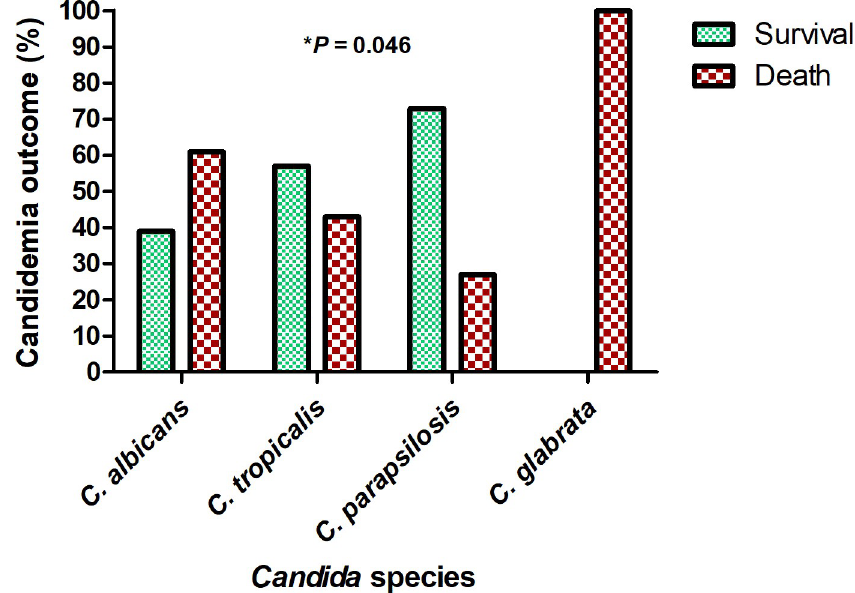
Fig 3. Outcome of candidemia according to the Candida species in a tertiary hospital in Northeast Brazil. � Chi- square ( X 2 ) test.